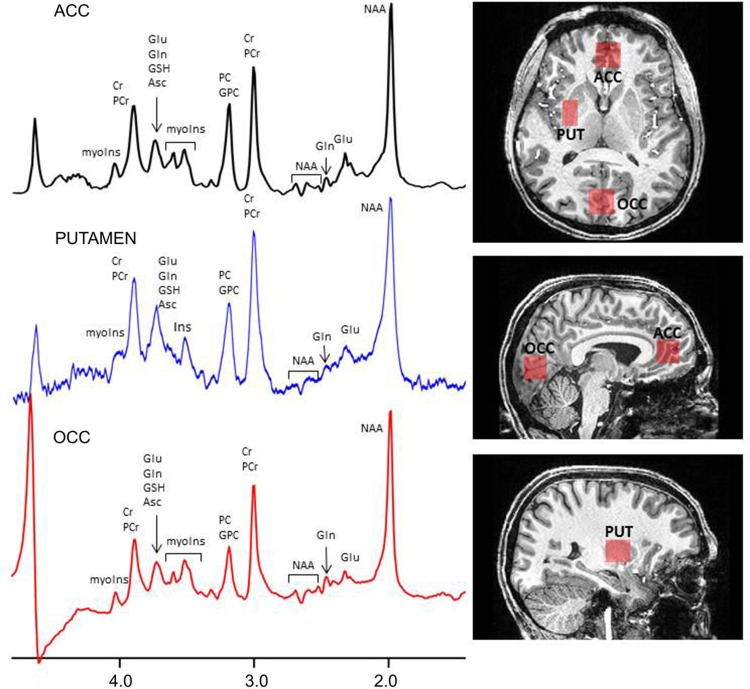
Voxel placement and representative spectra from the ACC, OCC and PUT. Glu, glutamate; Gln, glutamine; GSH, glutathione; Cr, creatine; PCr, phosphocreatine; myoIns, myo-inositol; PC, phosphocholine; GPC, glycerophosphocholine; NAA, N-acetylaspartate; Asc, ascorbate.